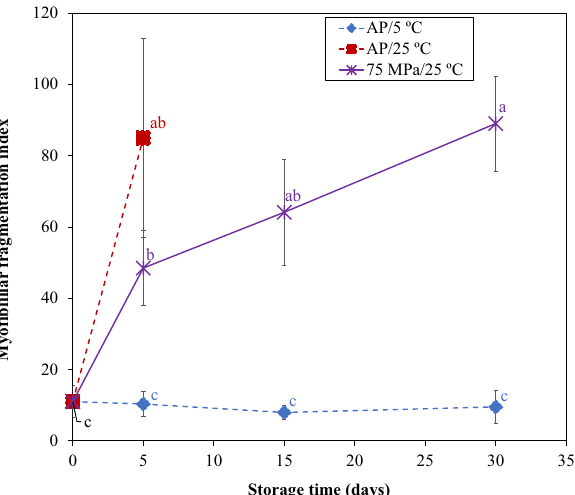
Figure 3. Myofibrillar fragmentation index of Atlantic salmon stored at 75 MPa/25 °C and AP/5 °C during 30 days, and at AP/25 °C during 5 days. Different letters denote significant differences (p < 0.05) between salmon samples stored at different conditions and time ( a – c